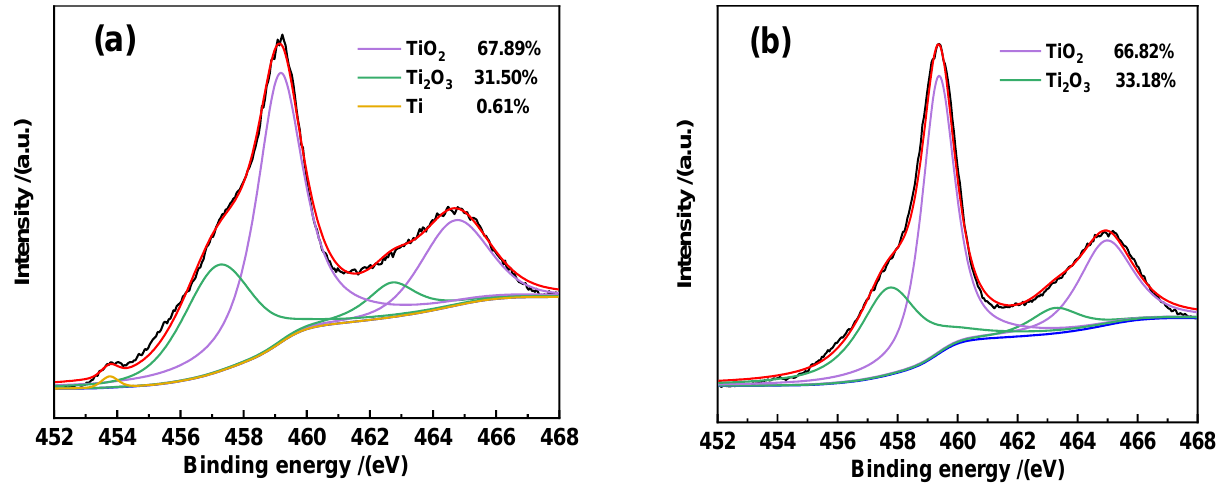
Figure 10. Detailed Ti spectra in passive films on the surface of ( a ) forged ( b ) SLMed Ti-6Al-4V al- loys.